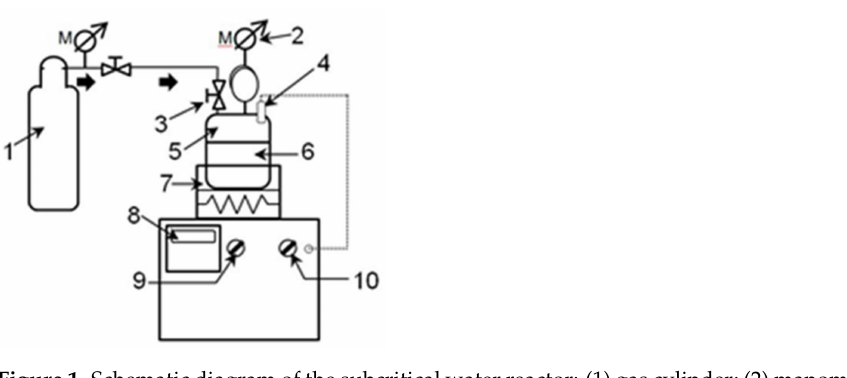
Figure 1. Schematic diagram of the subcritical water reactor: (1) gas cylinder; (2) manometer; (3) input gas valve; (4) thermocouple for temperature measurement; (5) coverlid of the reactor; (6) reaction vessel; (7) vibrating platform; (8) digital temperature controller; (9) main switch; (10) switch for the vibrating